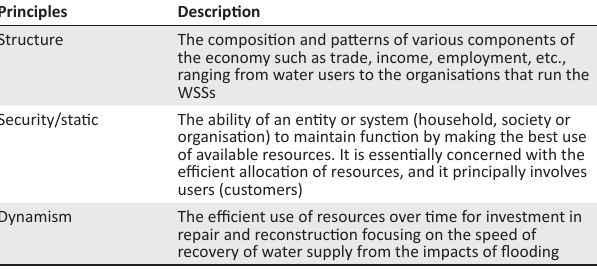
TABLE 7: Improved principles for economic dimension resilience. Principles